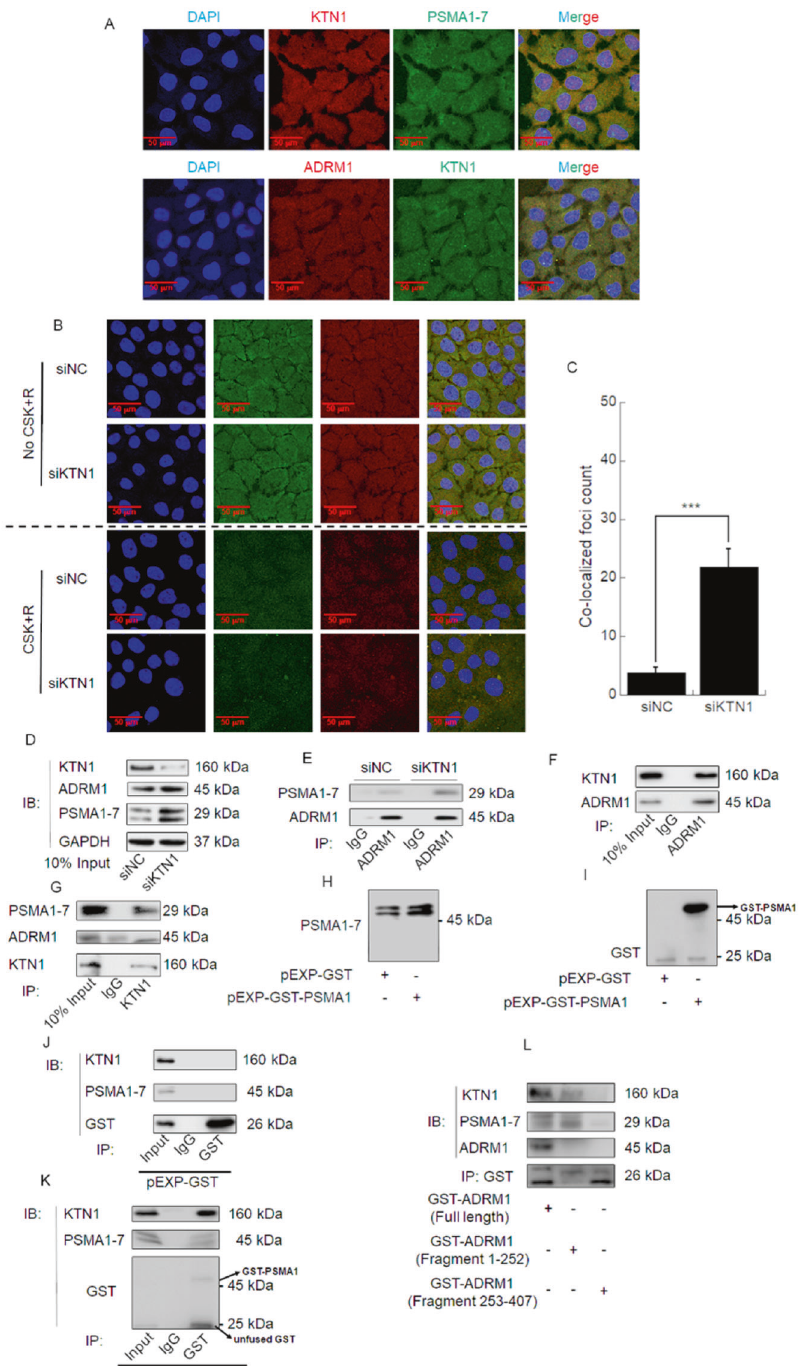
Fig. 7 KTN1 and PSMA1 interact with each other and competitively bind ADRM1 at amino acid residues Met1 – Ala252 in A431 cells. A Confocal immuno fl uorescent staining images showing co-localization between KTN1 and PSMA1 – 7 or ADRM1 in A431 cells. Representative of results from three biological replicates. B , C A431 cells were transfected with siKTN1 or siNC and then were treated with or without CSK buffer. Confocal immuno fl uorescent staining images show co-localization between PSMA1 – 7 and ADRM1 in A431 cells. Quanti fi ed foci count represents the means ± SD. Representative of results from three biological replicates. D , E A431 cells were transfected with siKTN1 or siNC. Total cell lysates were subjected to Co-IP and immunoblotting with anti-PSMA1 – 7, anti-ADRM1, or anti-KTN1. Representative of results from three biological replicates. F , G A431 cell lysates were subjected to Co-IP analysis. Representative of results from three biological replicates. H – K A431 cells were transfected with plasmid expressing GST or GST-tagged PSMA1(GST-PSMA1). Representative of results from three biological replicates. Total cell lysates were subjected to Co-IP and immunoblotting with anti-GST, anti-PSMA1 – 7 or anti-KTN1. Representative of results from three biological replicates. L A431 cells were transfected with plasmid expressing GST-tagged ADRM1 full length, GST-tagged ADRM1 1 – 252 amino acid residues or GST-tagged ADRM1 253 – 407 amino acid residues. Total cell lysates were subjected to Co-IP and immunoblotting with anti-GST, anti-ADRM1, anti-PSMA1 – 7, or anti-KTN1. Representative of results from three biological